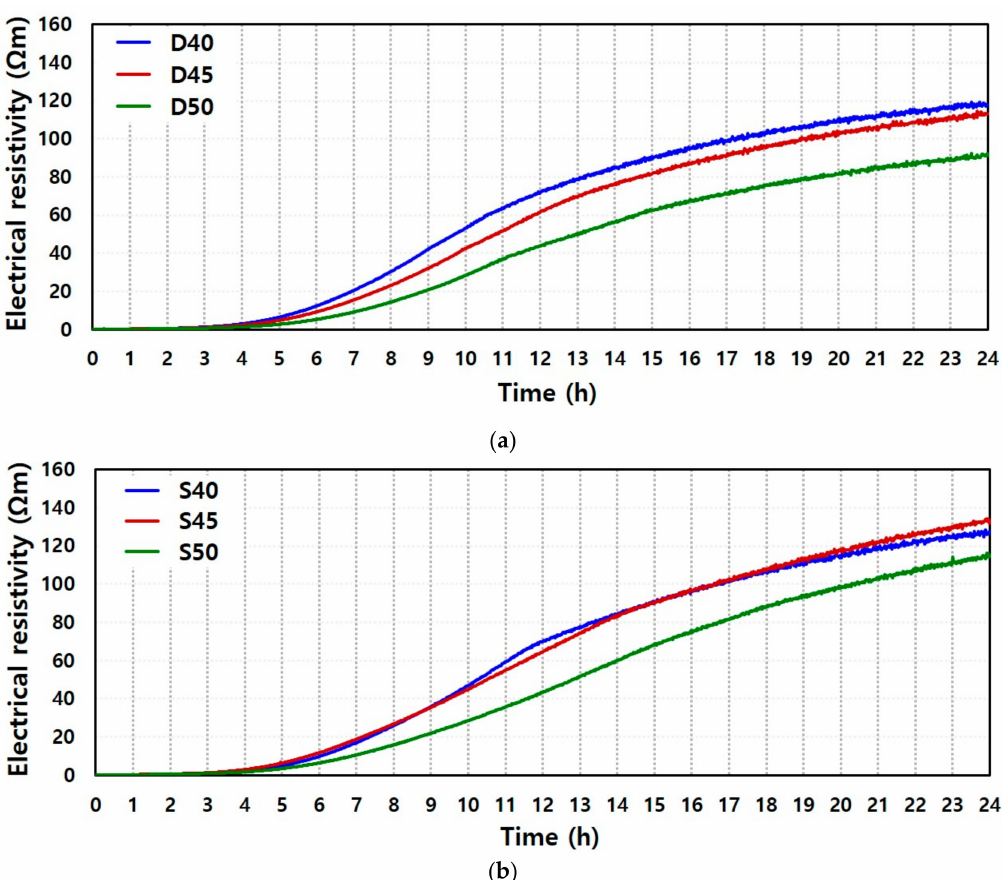
Figure 3. Comparison of measured electrical resistivity of ( a ) deionized water-mixed and ( b ) seawater- mixed AAS pastes with different a / b ratios; 40, 45, and 50 represent a / b ratios of 0.4, 0.45, and 0.5,